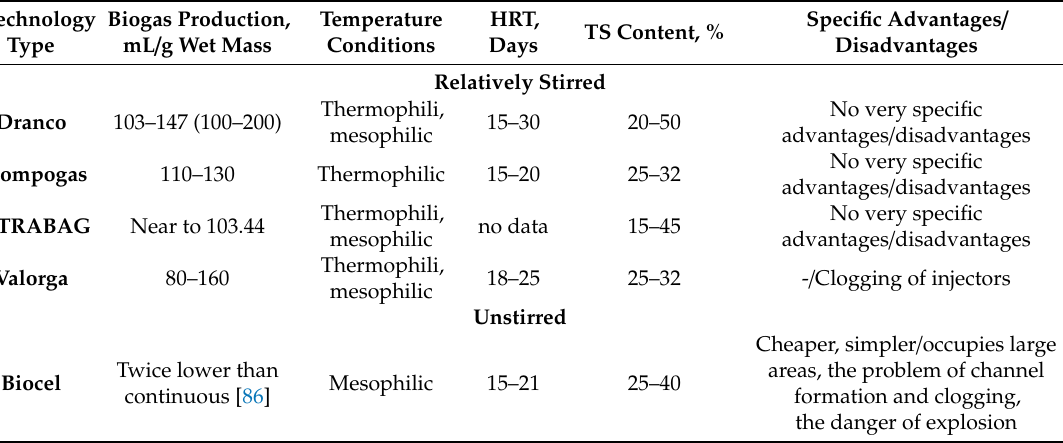
Table 2. Comparison of dry AD